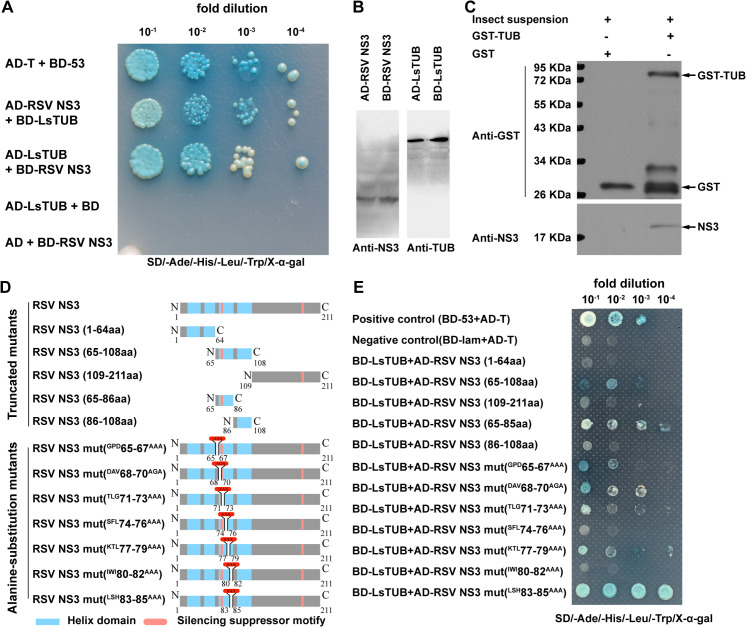
The interaction between LsTUB and RSV NS3 detected by yeast two-hybrid assay and GST pull-down assay.(A) Interactions between LsTUB and RSV NS3 proteins identified by yeast two-hybrid assays. Yeast cells were diluted 10−1 to 10−4 and plated onto QDO (SD-trp-leu-his-ade-20 mM3-AT) medium. Colonies growing on QDO were also assayed for β-galactosidase activity (blue color). Controls: AD-T + BD-53 (positive control); or AD-LsTUB + BD or AD + BD-RSV NS3 (negative control). Abbreviations: AD, activation domain, cloned in pGADT7; BD, bait domain, cloned in pGBKT7; LsTUB, Laodelphax striatellus, tubulin; NS3, nonstructural protein 3. (B) Western blot analysis of RSV NS3 and LsTUB in yeast strain Y2H Gold. (C) GST pull-down assays. LsTUB was fused to GST and incubated with viruliferous SBPH extracts or GST (control). Blots were probed with anti-NS3 or anti-GST antibodies. Insect suspension obtained from 50 viruliferous adults (femal/male ratio = 1:1), + means input,—means no input. (D) The schematic diagram of the wild-type RSV NS3 and 12 mutated RSV NS3 constructs. Five truncated mutants of NS3, including RSV NS3 1-64aa, RSV NS3 65-108aa, RSV NS3 109-211aa, RSV NS3 65-85aa and RSV NS3 86-108aa. Seven NS3 mutants with an alanine-substitution mutation, including RSV NS3 mut GPD65-67AAA, RSV NS3 mut DAV68-70AGA, NS3 mut TLG71-73AAA, NS3 mut SFL74-76AAA, NS3 mut KTL77-79AAA, NS3 mut IWI80-82AAA and NS3 mut LSH83-85AAA. (E) Interactions between LsTUB and mutated RSV NS3 proteins in yeast two-hybrid assays. Controls: AD-T + BD-53 (positive control) or AD-T + BD-Lam (negative control).